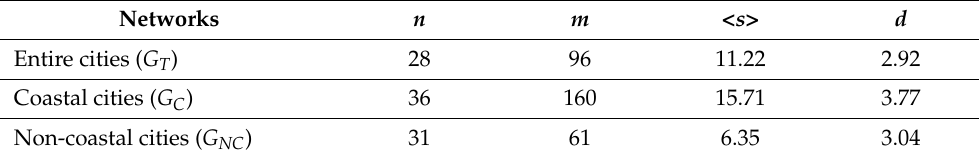
Table 4. Attributes of the groundwater-centered CB